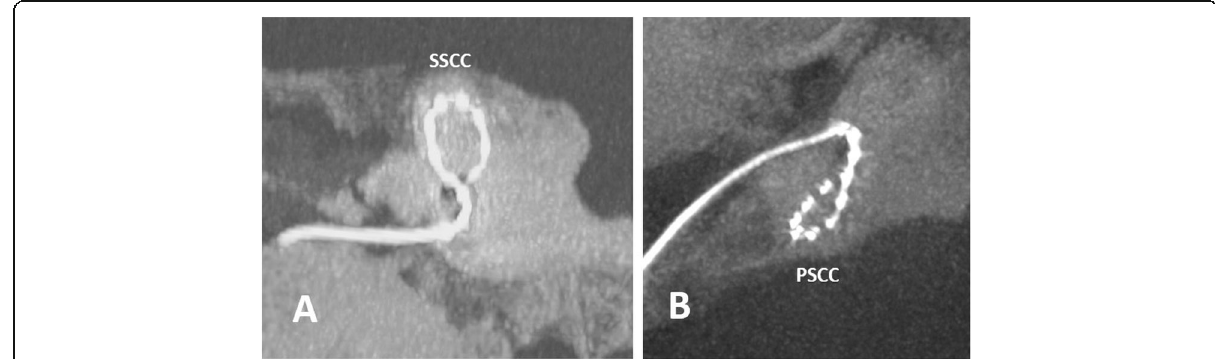
Fig. 33 a A 86-year-old male patient, with immediate postoperative nausea. CBCT paracoronal maximum intensity projection image shows the